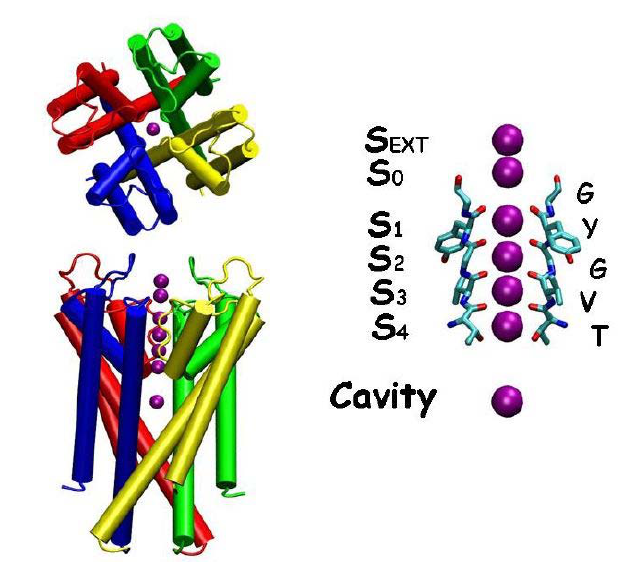
Fig. 4 Schematic diagrams showing the topology of KcsA with the transmembrane he- lices represented by cylinders and K+ ions by purple spheres. Top left figure shows the arrangement of all four subunits looking from the extracellular side directly down through the pore. Bottom left figure shows a cross-sectional view through the channel. Right fig- ure shows and schematic structure of the cation binding sites in the selectivity filter of KcsA channel, TVGYG motif. Only two subunits are shown for clarity. The extracellular side is on the top and the intracellular side is at the bottom. Binding sites are labelled SEXT, S0-S4 and